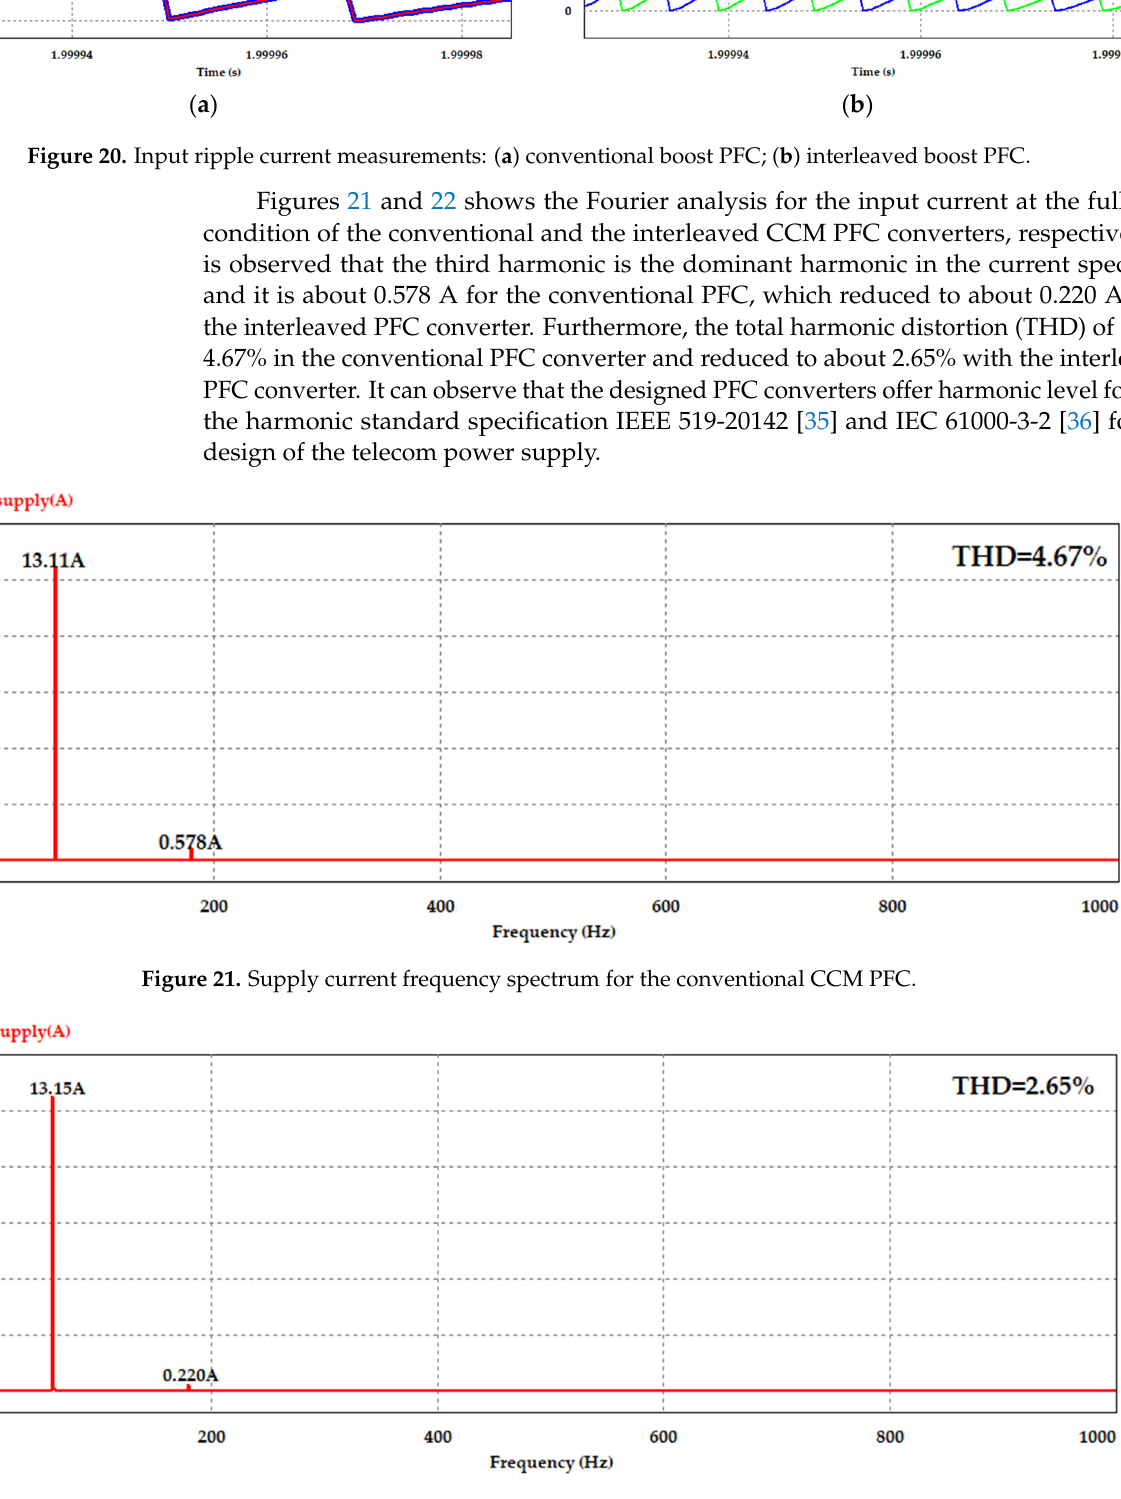
21 of 28 Figure 18. Output voltage dynamic performance with different input voltage for the conventional CCM PFC. Figure 19. Output voltage dynamic performance with different input voltage for the interleaved CCM PFC. To investigate the advantage of the current ripple cancellation in the interleaved PFC converters over the conventional PFC converters, the input current ripple for both con- verters is measured at the same switching period from 1.999925 to 1.999985. Figure 20 shows the waveforms of the boost converter input current and inductors currents for the